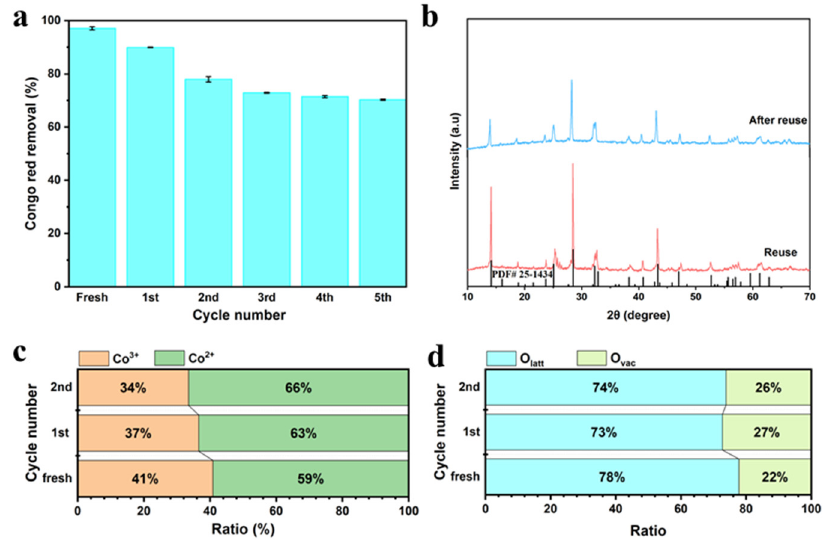
Figure 12. ( a ) Cyclic degradation performance, the error bars represent the standard deviation (n = 3); ( b ) the XRD of reused CMO-8 and after reuse CMO-8; the ratio of Co 2+ , Co 3+ , O latt , O vac ( c , d ).